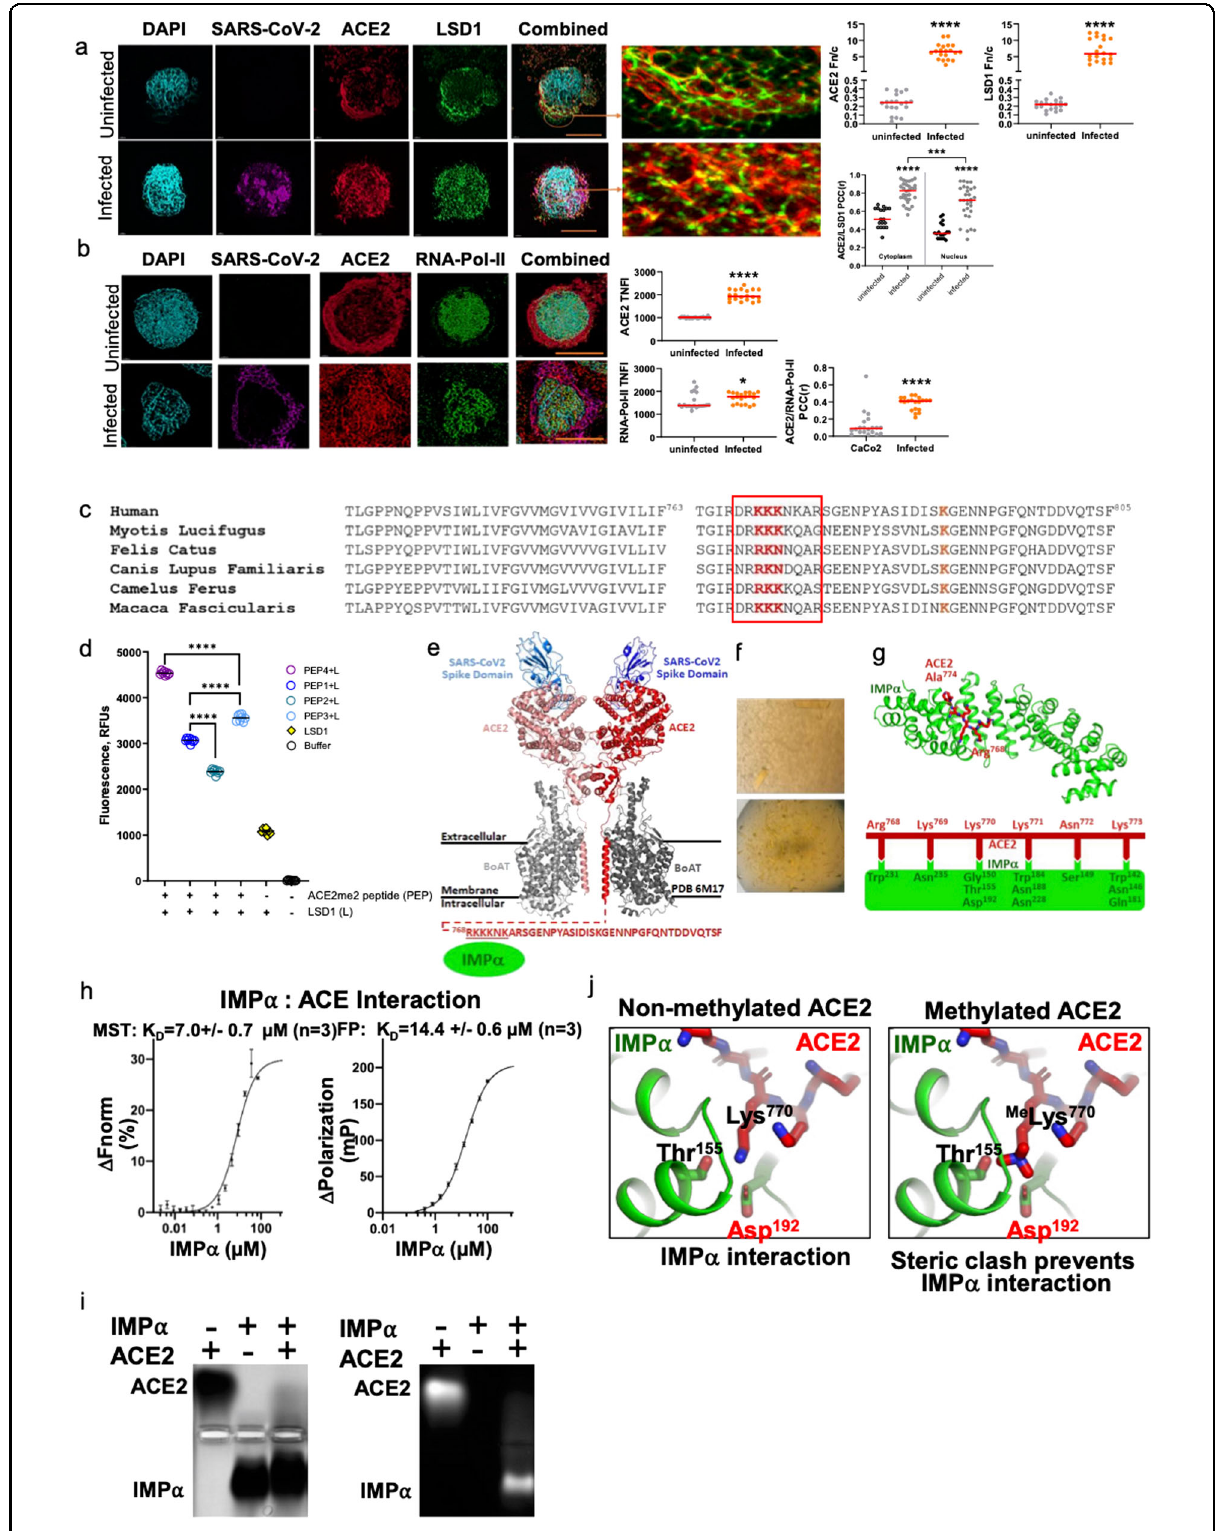
Fig. 4 (See legend on next